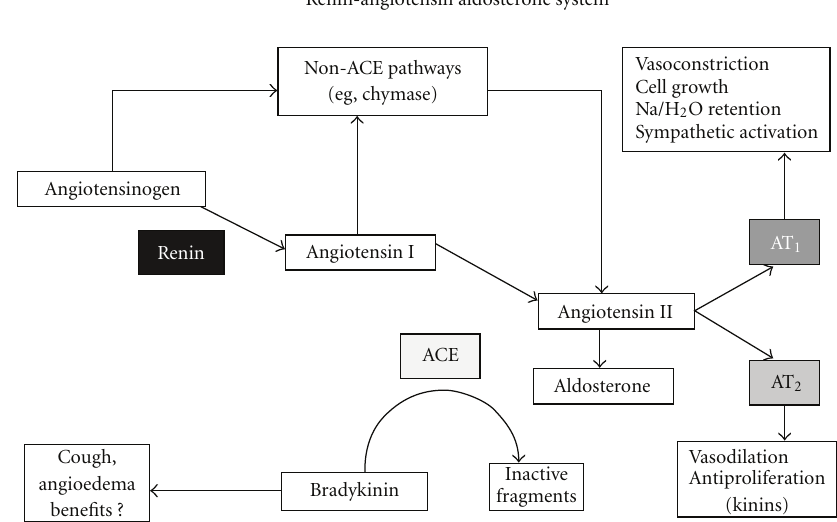
Figure 1: Renin-angiotensin aldosterone system. Reprinted with permission from Ibrahim [8].